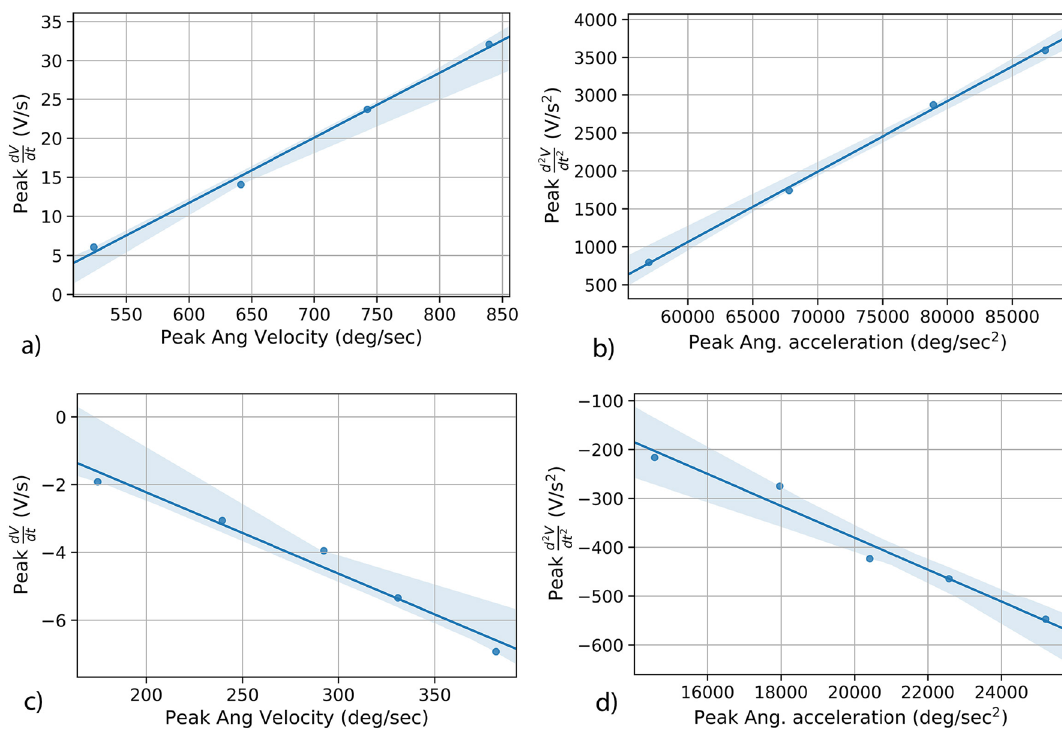
Figure 6. ( a ) and ( c ) relationship between the FENG’s voltage response and the peak angular velocity during hyperflexion and hyperextension. Similarly, ( b ) and ( d ) show the relationship between FENG’s voltage response and the peak angular acceleration. The shaded region shows the 95 % confidence interval of the fitted